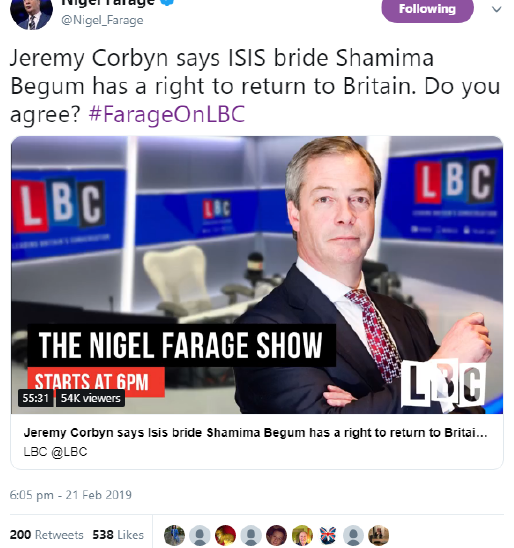
Figure 11. Tweet from Brexit Party leader Nigel Farage, 21 February 2019.